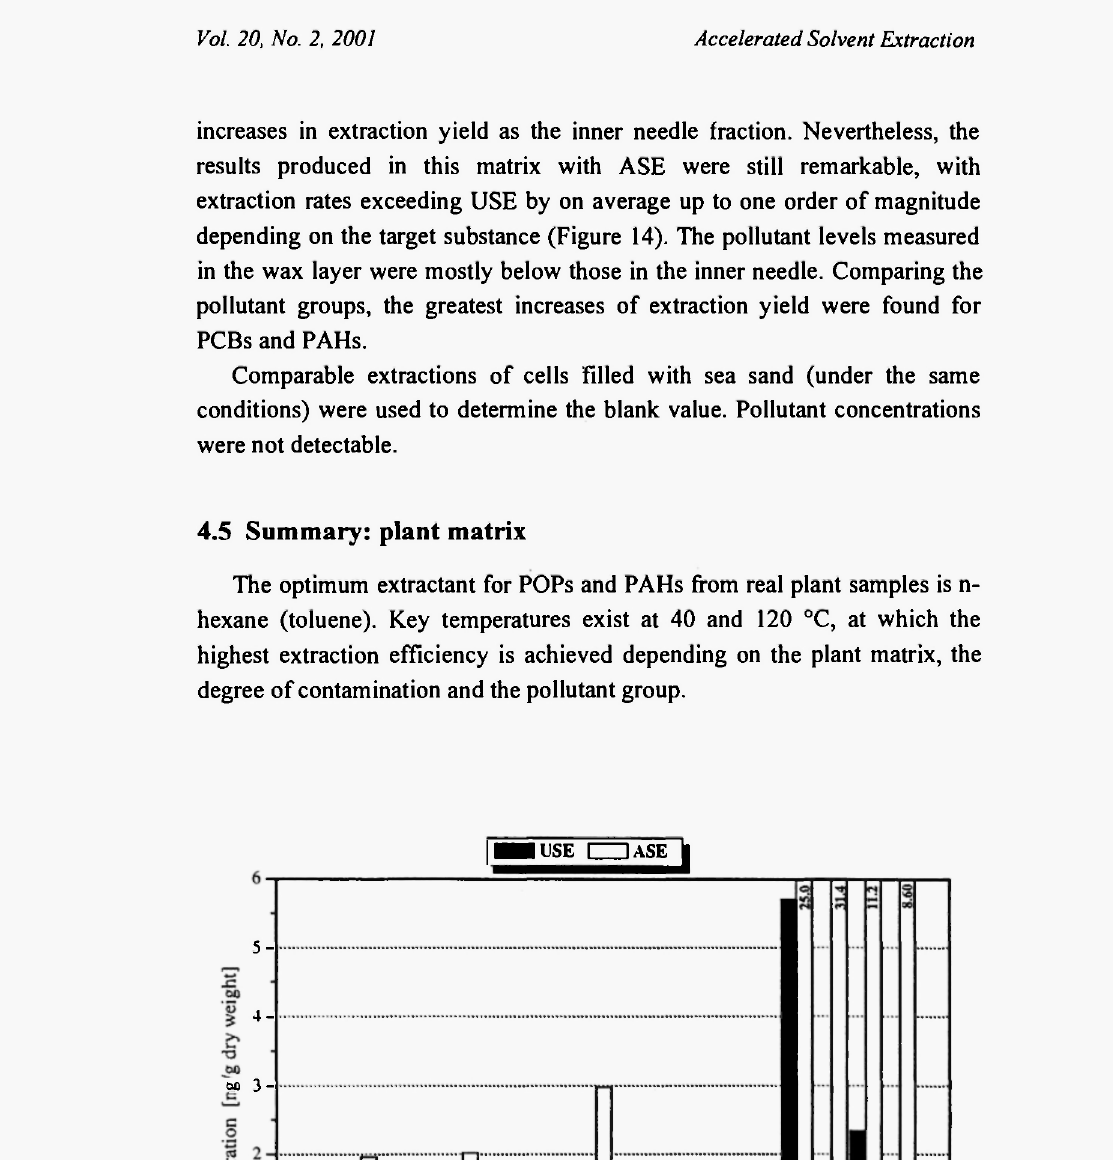
Fig. 14: Comparison between ASE and USE using mixed samples of the wax fraction of pine